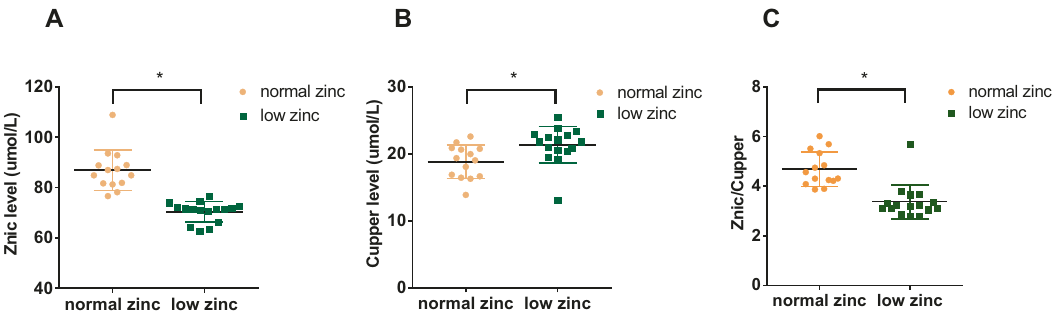
Fig. 4 Scatter diagrams showing the plasma levels of zinc, copper, and zinc/copper of patients with DN. A Plasma zinc levels were signi fi cantly lower in the low-zinc group than in the normal-zinc group (* P < 0.05). B Plasma copper levels were signi fi cantly higher in the low- zinc group than in the normal-zinc group (* P < 0.05). C The ratio of zinc and copper in the low-zinc group was signi fi cantly lower than that in the normal-zinc group (* P <